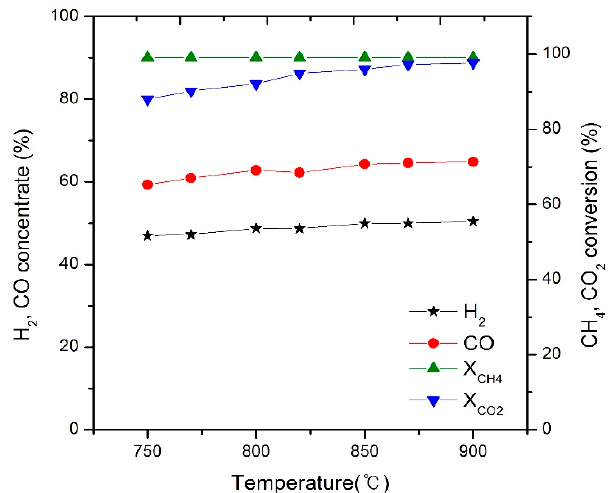
Figure 8. E ff ect of temperature on CO 2 and CH 4 conversion rates during biogas reforming at R = 0.7 (O 2 /CH 4 = 0.2).